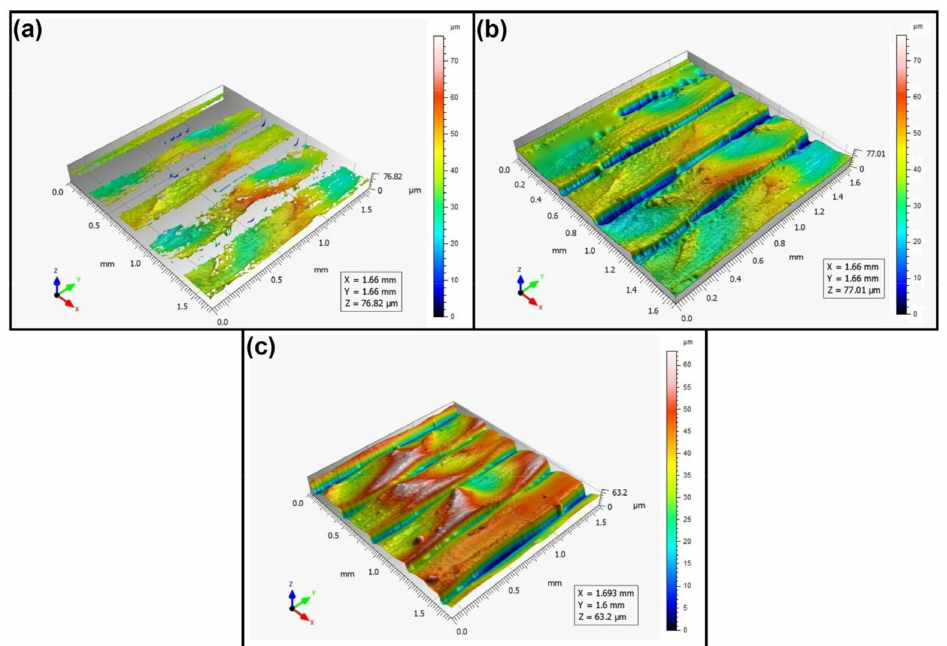
Figure 8. Surface topography of the element 3D printed using FDM technology (Pd = 90 ◦ ). ( a ) Talysurf CCI—without filling non-measured points, ( b ) Talysurf CCI—after filling non-measured points, ( c ) Talysurf PGI 1230.